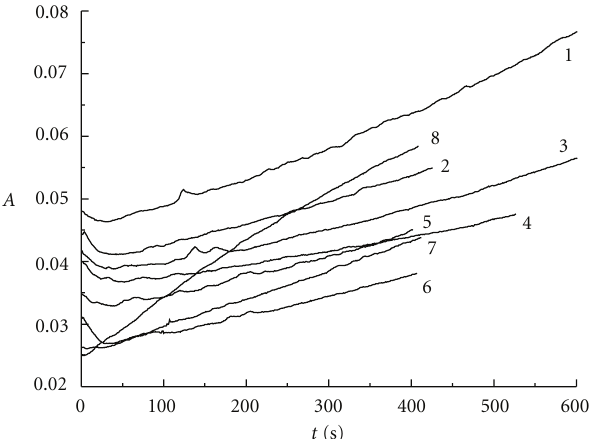
Figure 8: The absorbance versus reaction time for ClO 2 -I − -H + system at 460 nm ( r = 3 . 26): curve 1: pH = 7 . 0; curve 2: pH = 5 . 7; curve 3: pH = 5 . 0; curve 4: pH = 4 . 5; curve 5: pH = 4 . 0; curve 6: pH = 3 . 6; curve 7: pH = 2 . 0; curve 8: pH = 1 . 0.